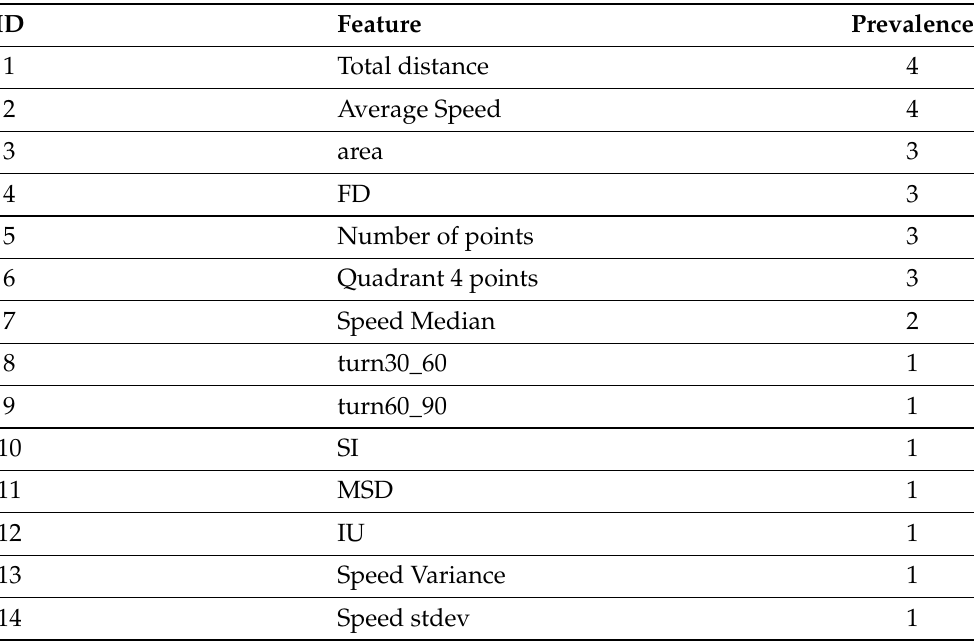
Table A8. Selected features’ prevalence based of Features-Selection